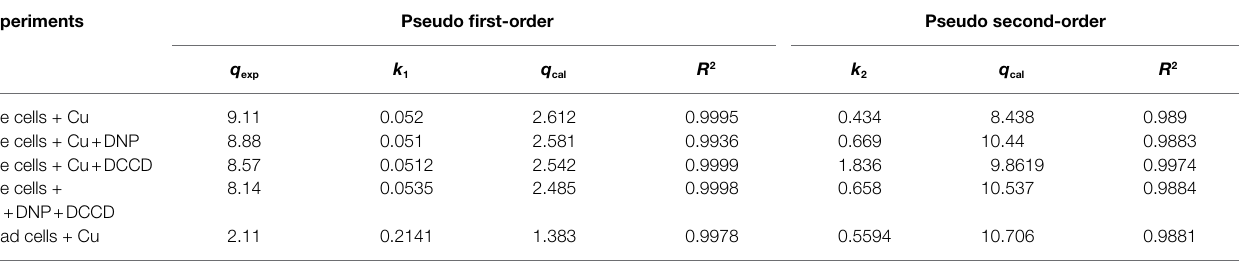
TABLE 3 | Pseudo-order (first and second) kinetic model constants for B. altitudinis MT422188 biosorption. Experiments